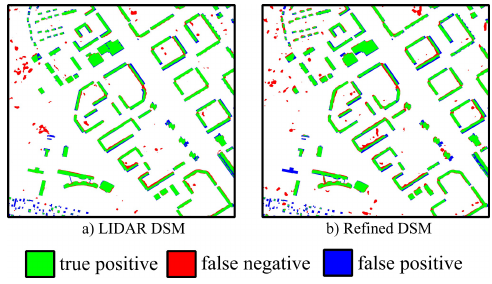
Figure 4. Pixel-based evaluation of footprint extraction from LIDAR and generated DSMs compared to OSM. Table 1. FCN-score metrics evaluated on “real” DSM vs “fake” DSM compared to